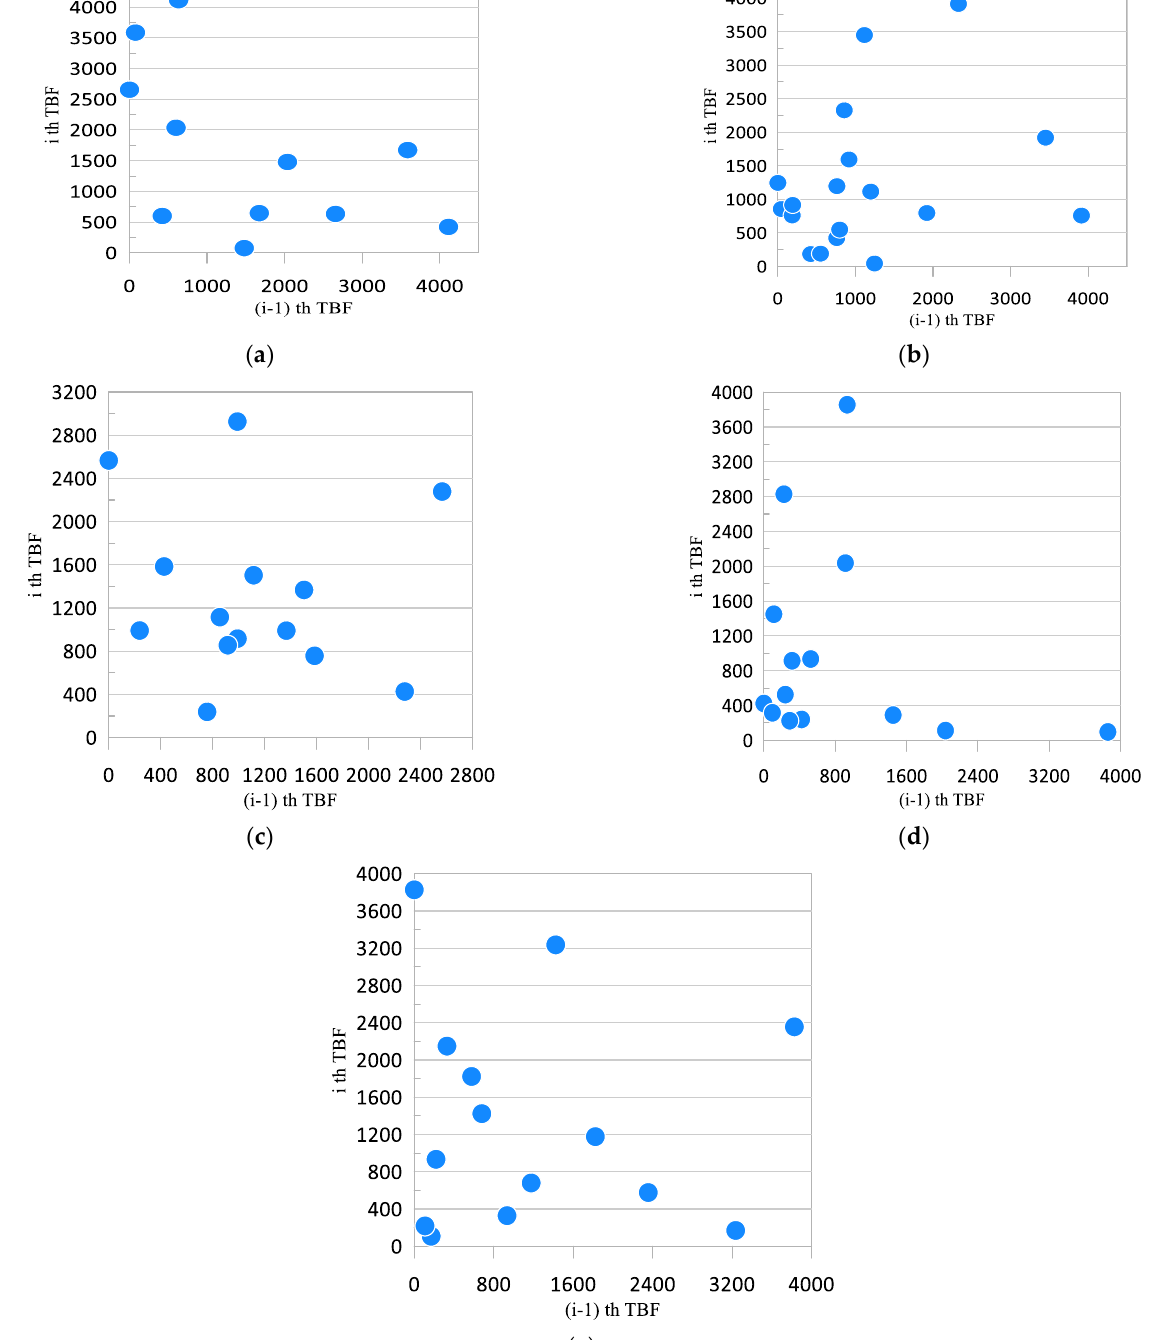
Figure 5. ( a ). Serial correlation test of TBF data for air supply subsystem; ( b ). Serial correlation test of TBF data for self- starting subsystem; ( c ). Serial correlation test of TBF data for fuel supply subsystem; ( d ). Serial correlation test of TBF data for lubrication subsystem and ( e ). Serial correlation test of TBF data for cooling subsystem.